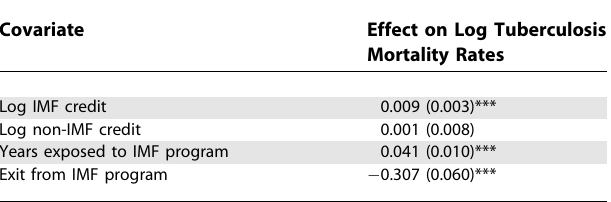
Table 2. Dynamic Association of IMF Lending Programs with Log Tuberculosis Mortality Rates Covariate